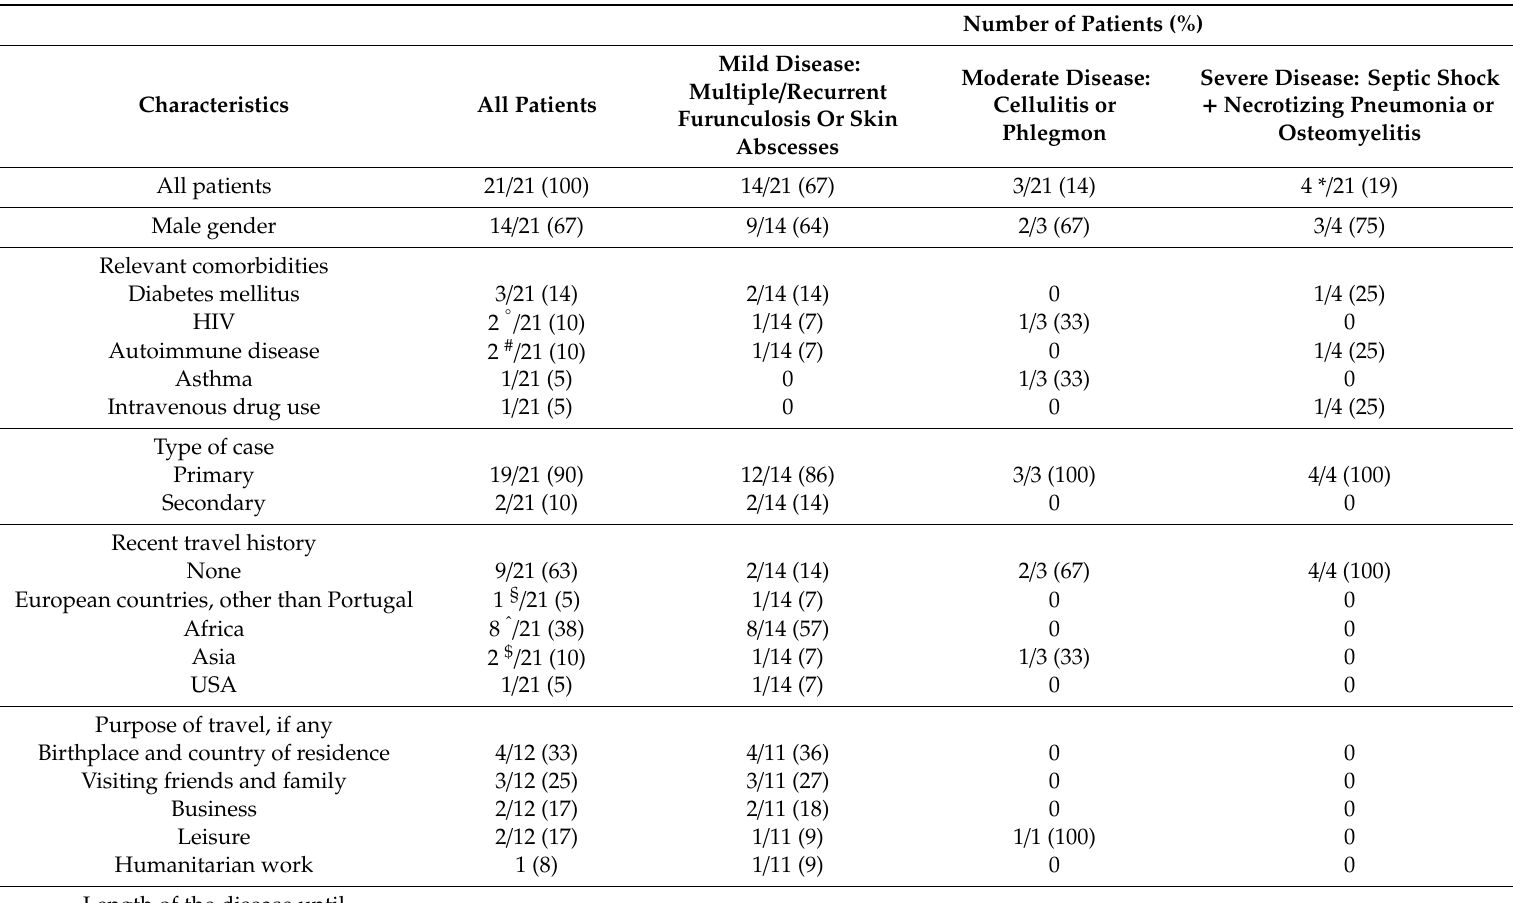
Table 1. Characterization of patients with Panton-Valentine leukocidin-producing Staphylococcus aureus (PVL-SA)